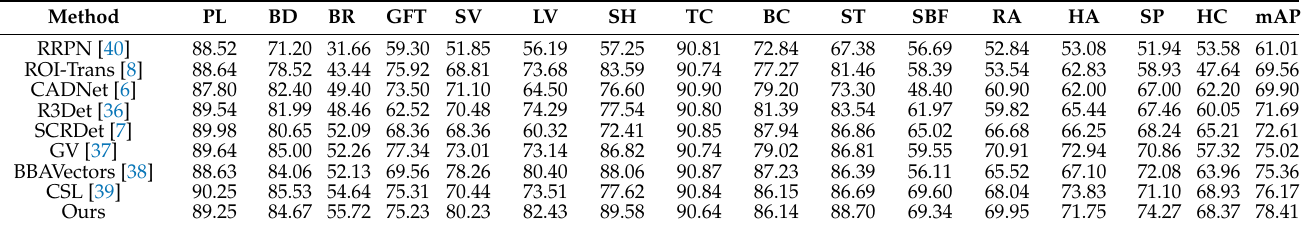
Table 5. Comparisons on DOTA with the state-of-the-art detectors. We chose an IoU threshold of 0.5 when calculating the AP.